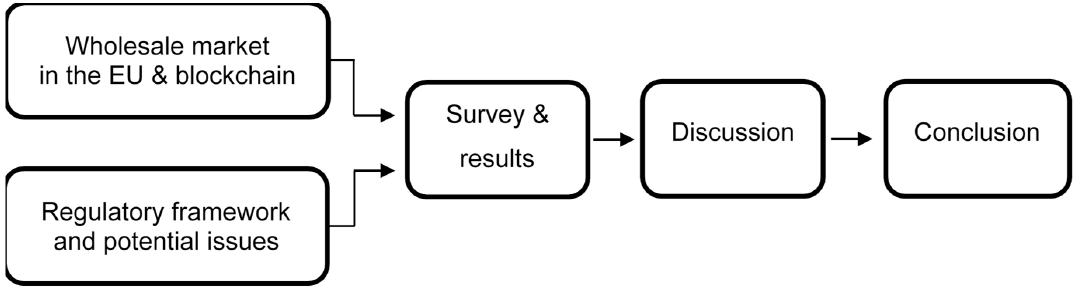
Figure 1. This article’s structure.